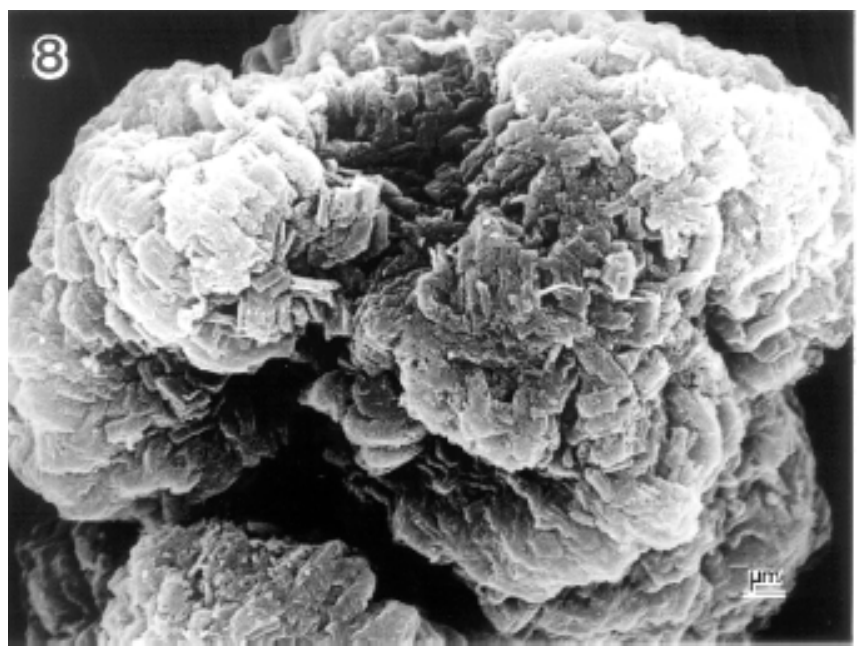
Fig. 8 – SEM of an agglomerate after being heated at 1050 ◦